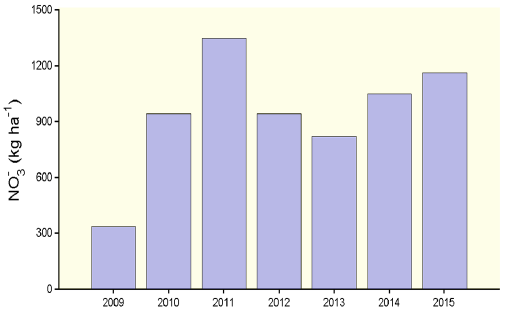
Figure 5. Yearly total nitrate mass of the entire vadose zone per year of